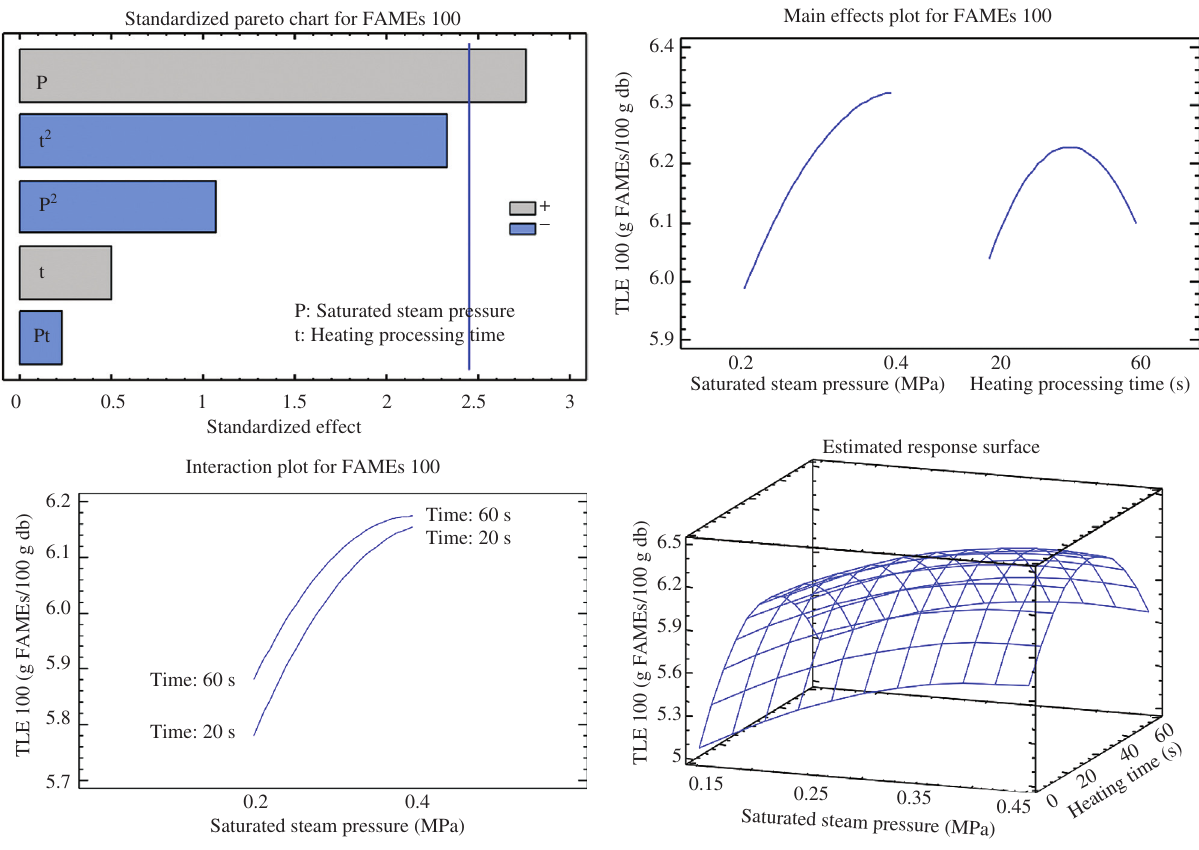
Figure 4 Pareto chart, general trends, cross effects and response surface of instant controlled pressure drop (DIC) operating parameter for fatty acid methyl esters (FAMEs) resulting from in situ transesterification of DIC-treated microalgae with initial water content of 100%